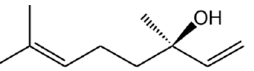
Figure 1. (R) ‐ ( ‐ ) ‐ linalool (Licareol), a potent flavour with flowery ‐ wood odour notes.